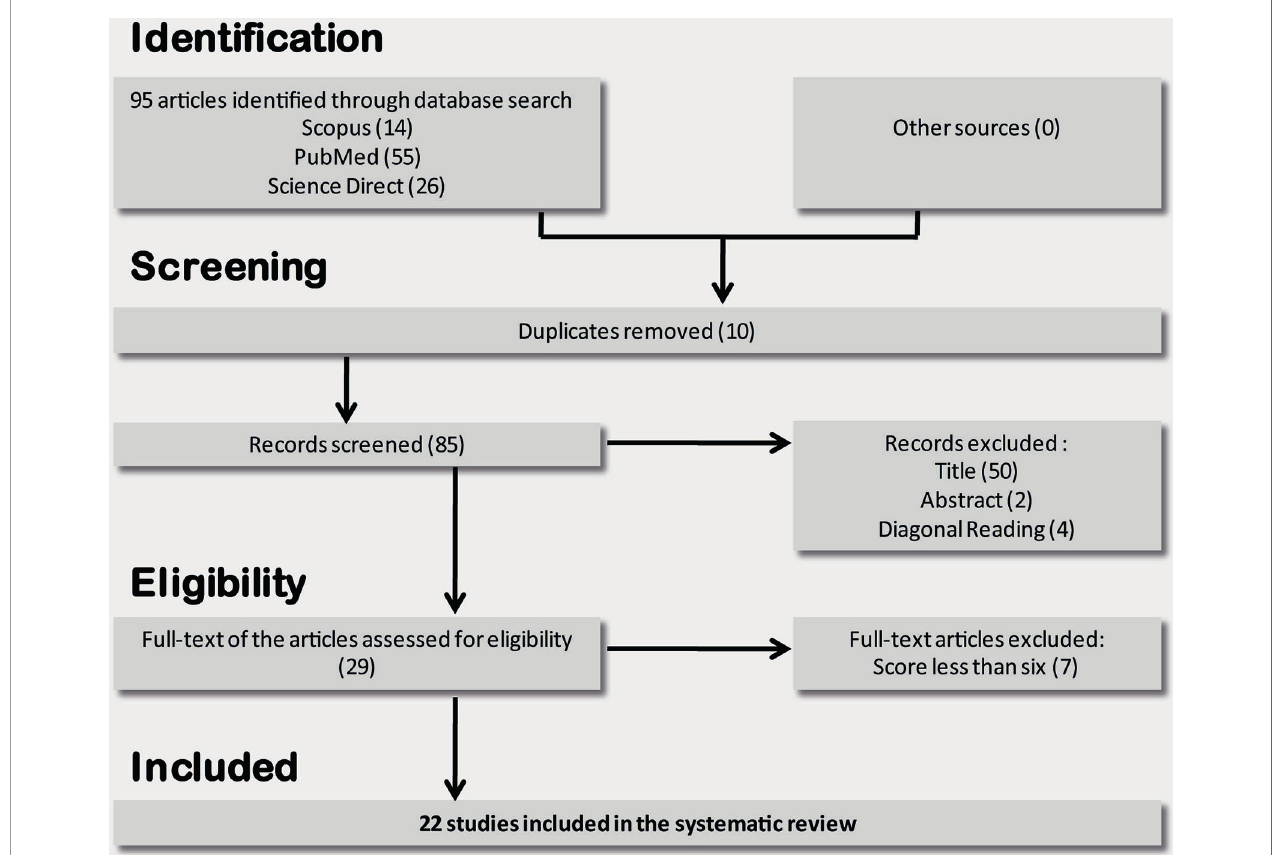
FIGURE 1 | Flow diagram through the different phases of studies selection for systematic review.